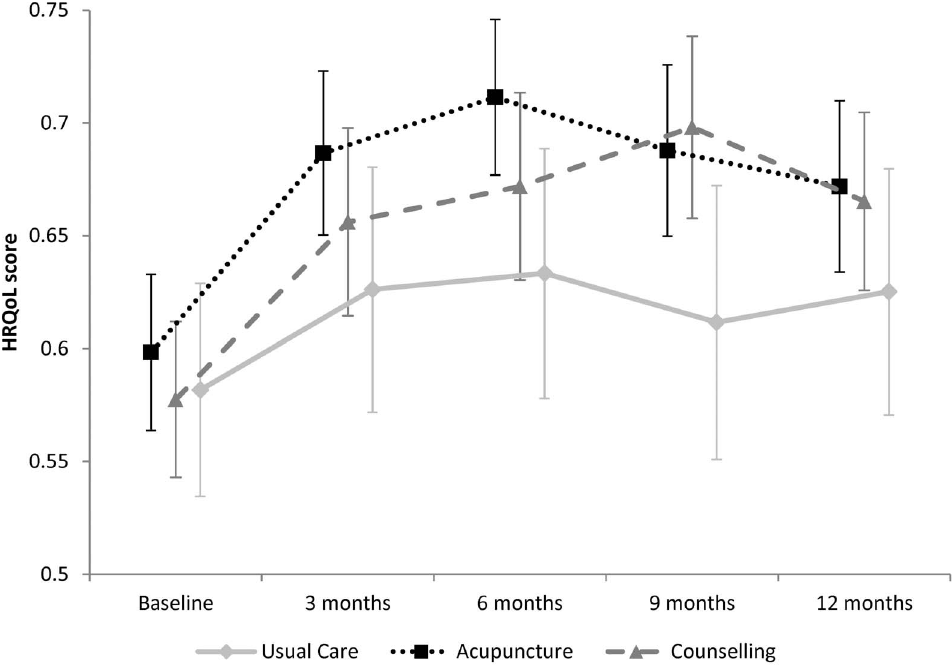
Figure 1. Health-related quality-of-life scores over time and by